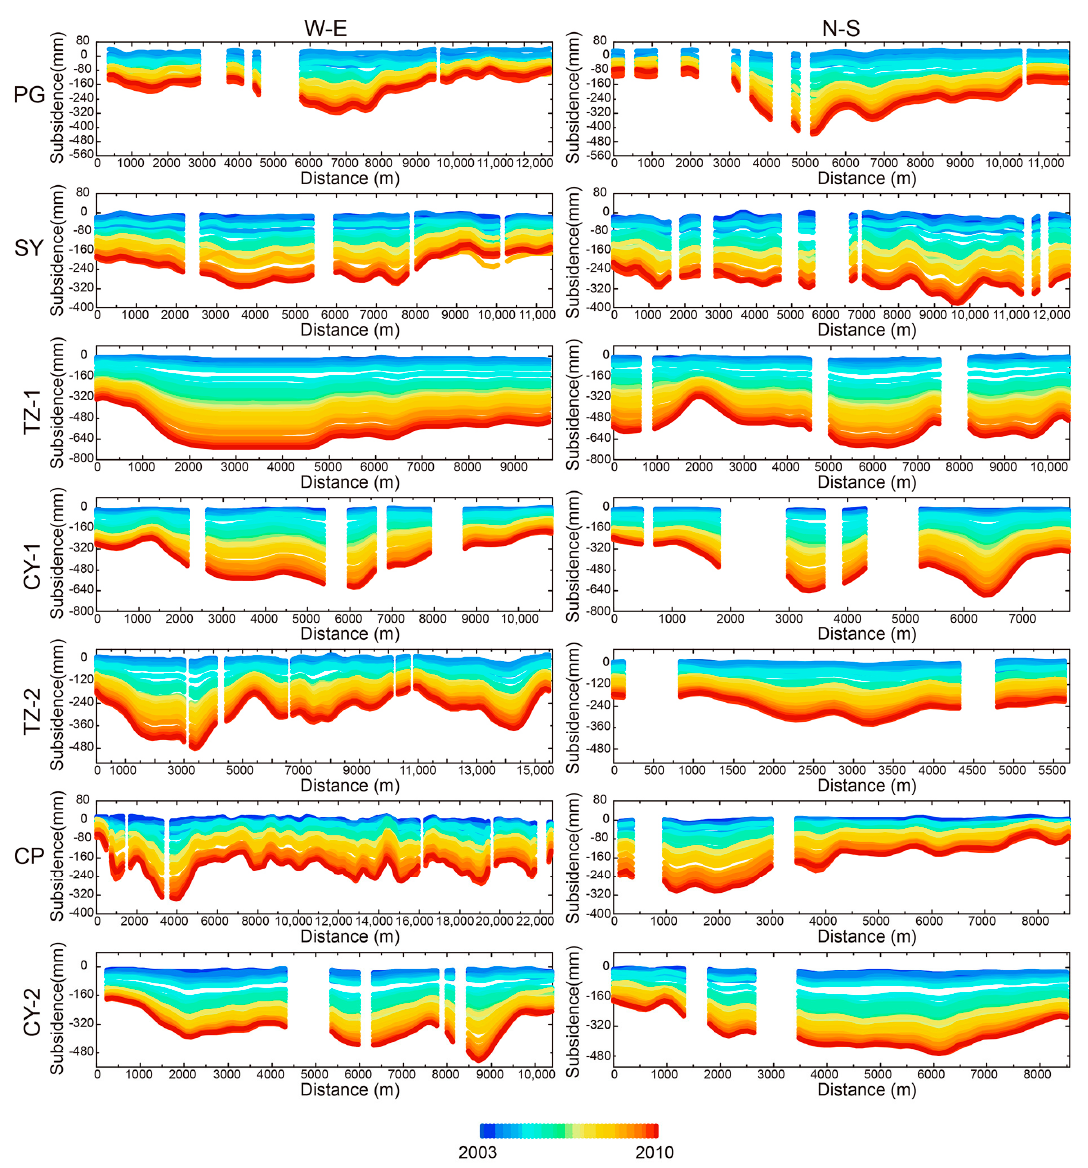
Figure 3. Profiles of InSAR vertical displacement time series (June 2003–August 2010) marked by red dashed line in Figure 2a. The gaps occur where noise covers up the pixels throughout the interferograms, and the pixels are excluded as described in Section 3.1.